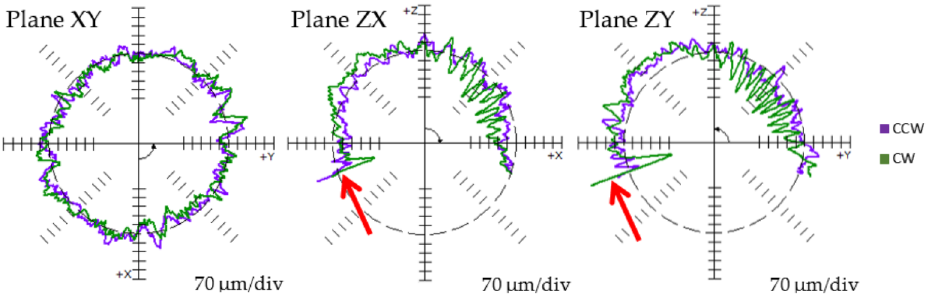
Figure 4. Polar graphs of the volumetric analysis evaluation—LR Mate